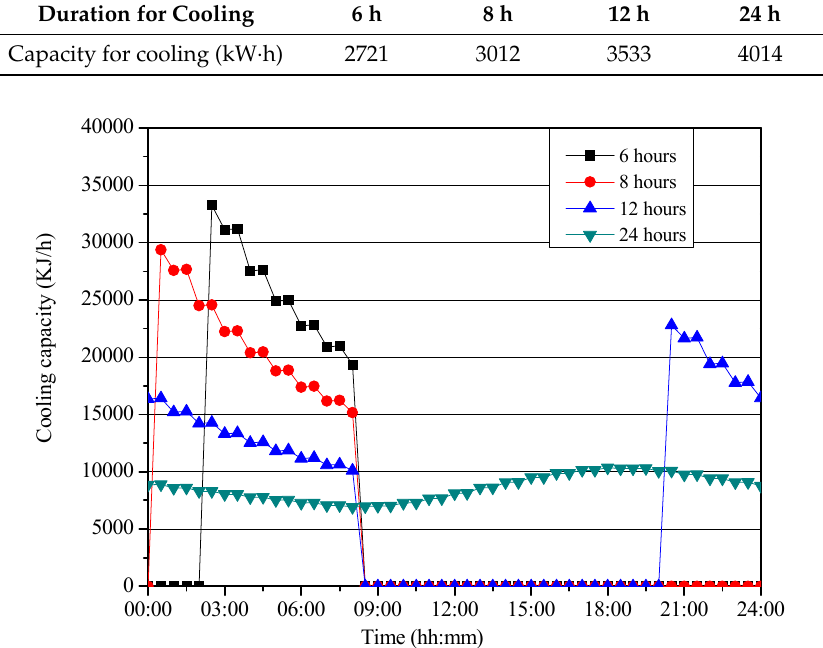
Figure 12. Pattern of variations in cooling capacity of embedded tubes with various durations for cooling in a typical 24-h day. Table 3. Total capacity of the embedded tubes for cooling during the cooling period with various durations for cooling.